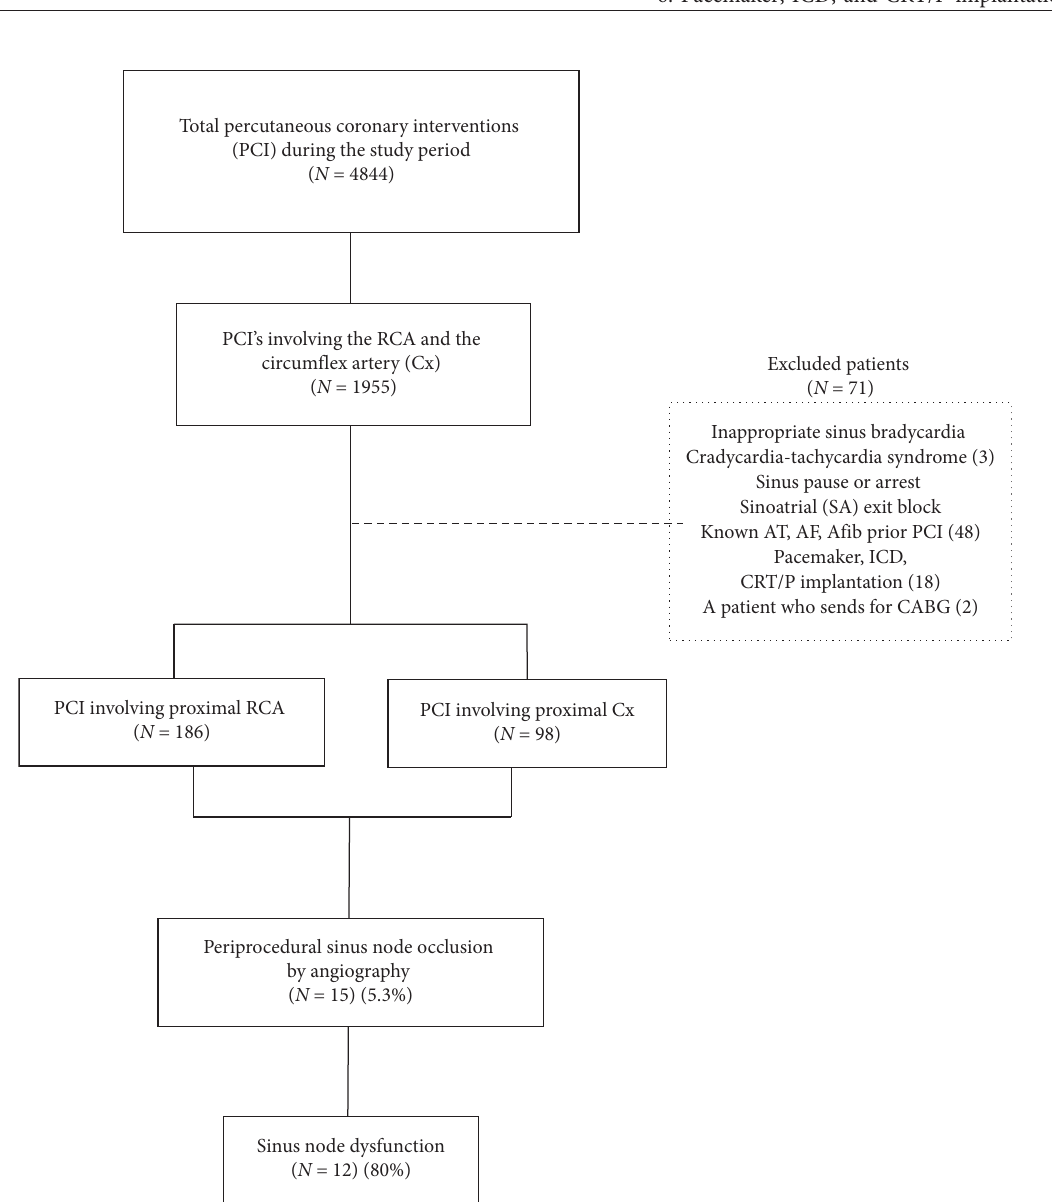
Figure 1: Study plan. AT, atrial tachycardia; AF, atrial flutter; AFib, atrial fibrillation; PCI, percutaneous coronary